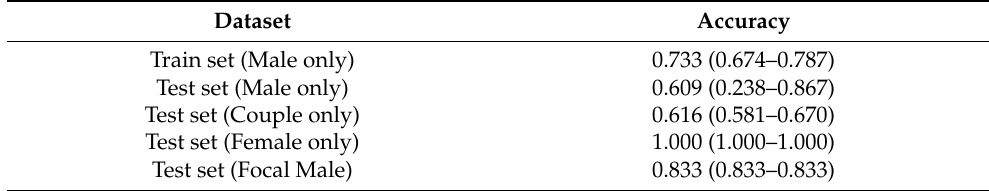
Table 3. Classification performance of each